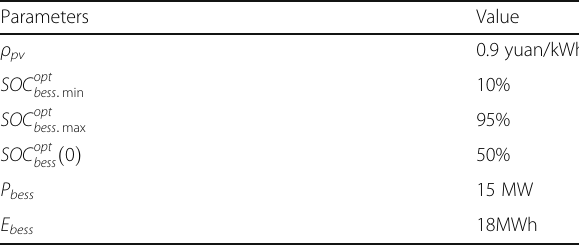
Table 1 Calculation parameters